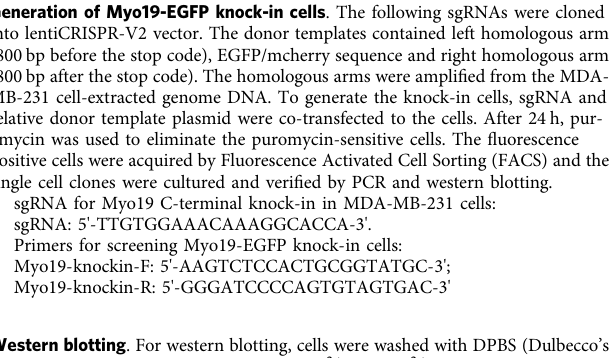
Fig. 4 Myo19 maintains mitochondria membrane potential and affects OXPHOS. a Left: representative thermographs of MDA-MB-231 WT and Myo19 KO cells stained with 100 nM TMRE for 20 min. Scare bar: 20 μ m. Right: quanti fi cation of TMRE fl uorescence intensity per cell. Data are shown as mean ± SD. N WT = 22, N Myo19 KO = 28. **** P < 0.0001. Signi fi cance ( P -value) was evaluated by two-sided t -test. Source data are provided as a Source Data fi le. b Flow cytometry analysis of WT and Myo19 KO cells stained with 100 nM TMRM for 20 min. 5 μ M FCCP treatment for 10 min was used as positive control. Gating/sorting strategy was performed according to product manual. c Quanti fi cation of relative ATP abundance in WT and Myo19 KO cells. Data are shown as mean ± SD. N WT = 3, N Myo19 KO = 3 independent samples. ** P = 0.0017. Signi fi cance ( P -value) was evaluated by two-sided t -test. Source data are provided as a Source Data fi le. d The representative curves of extracellular acidi fi cation rate (ECAR) in MDA-MB-231 scramble and Myo19 knock down (Myo19 KD) cells. Glucose:4.5 g/L; Oligomycin: 1 μ M; 2-DG: 50 mM. Data are shown as mean ± SD. N scramble = 11, N Myo19 KD = 9 independent samples. Source data are provided as a Source Data fi le. e Quanti fi cation of basal and maximal ECAR. Data are shown as mean ± SD. N scramble = 11, N Myo19 = 9 independent samples. **** P < 0.0001. ns, no signi fi cance. Signi fi cance ( P -value) was evaluated by two-sided t -test. Source data are provided as a KD Source Data fi le. f The representative curves of oxygen consumption rate (OCR) in scramble and Myo19 KD cells. Oligomycin: 1 μ M; FCCP:1 μ M; Rotenone: 1 μ M. Data are shown as mean ± SD. N scramble = 10, N Myo19 KD = 10 independent samples. Source data are provided as a Source Data fi le. g Quanti fi cation of basal and maximal OCR. ns, no signi fi cance. Data are shown as mean ± SD. N scramble = 10, N Myo19 KD = 10 independent samples. **** P < 0.0001. Signi fi cance ( P -value) was evaluated by two-sided t -test. Source data are provided as a Source Data fi le. h Growth curves of scramble and Myo19 KD cells grown in medium supplemented with the indicated monosaccharides. Left: glucose-based medium. Data are shown as mean ± SD. N scramble = 5, N Myo19 = 5 independent samples. * P = 0.0449. Right: galactose-based medium. Data are shown as mean ± SD. N = 5, N = 5 independent scramble Myo19 KD KD samples. ** P = 0.0011. Signi fi cance ( P -value) was evaluated by two-sided t -test. Source data are provided as a Source Data